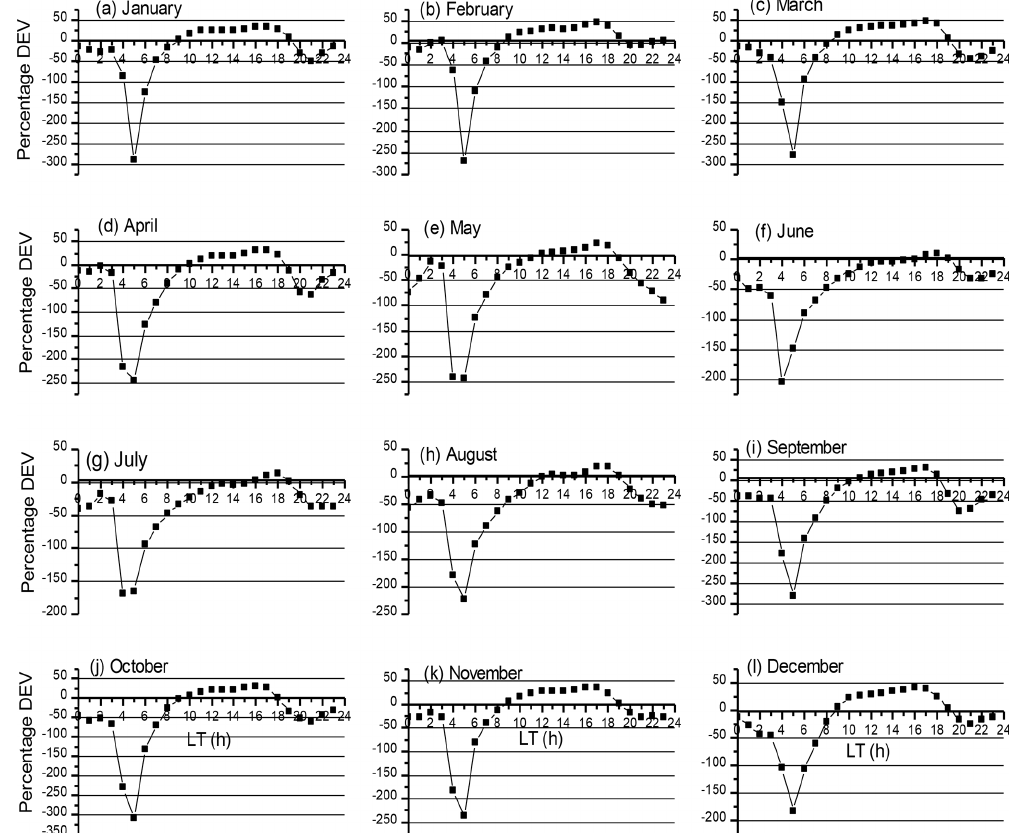
Figure 8. Percentage deviation of IRI-2016 from OBS-TEC for year